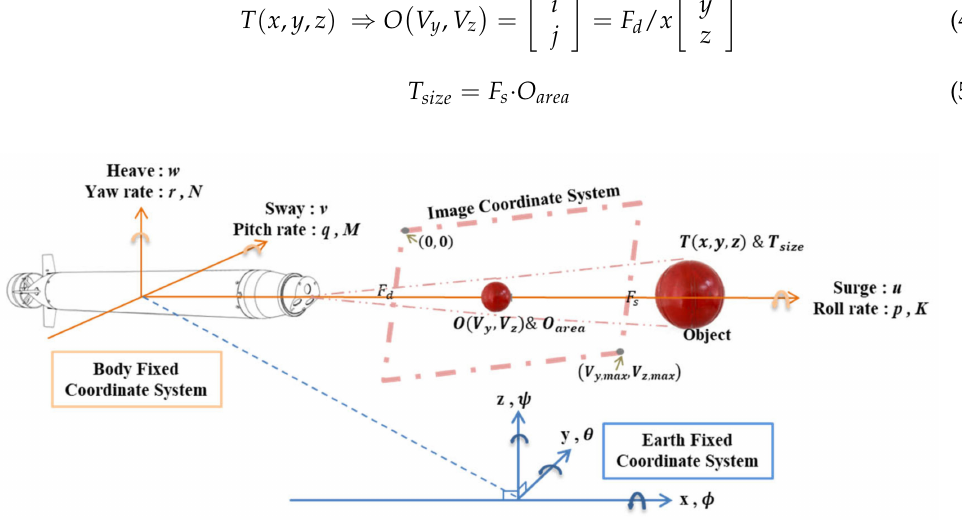
Figure 7. Relationship between the earth-fixed, body-fixed, and vehicle image coordinate